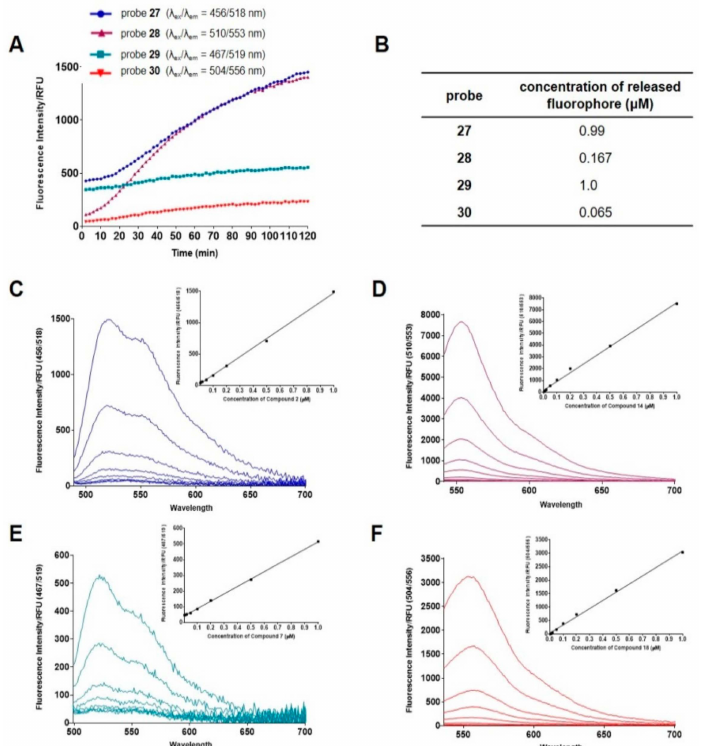
Figure 7. Kinetic study of NTR-responsive fluorescent probes and fluorescence calibration curves of corresponding fluorophores. ( A ) Plot of fluorescence emission of probes (1.0 µ M) with reaction time in the presence of 10 µ g / mL of NTR, NADH (500 µ M), PBS (pH 7.4), and incubation at 37 ◦ C; ( B ) Calculated concentrations of the corresponding fluorophores released from NTR-responsive fluorescent probes during NTR reaction; ( C – F ) Calibration curves at concentrations of 0.005, 0.01, 0.02, 0.05, 0.1, 0.2, 0.5, and 1.0 µ M of fluorophore (Inset: Linear regression graph); Concentration-dependent changes